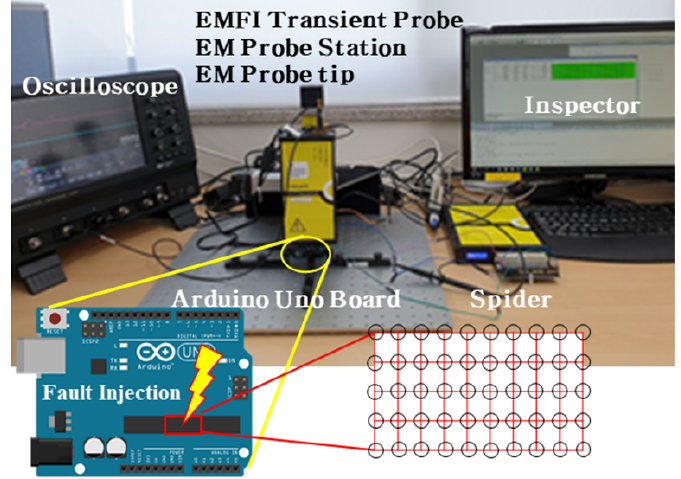
Figure 8. Electromagnetic fault injection experimental setup and fault injection location on the